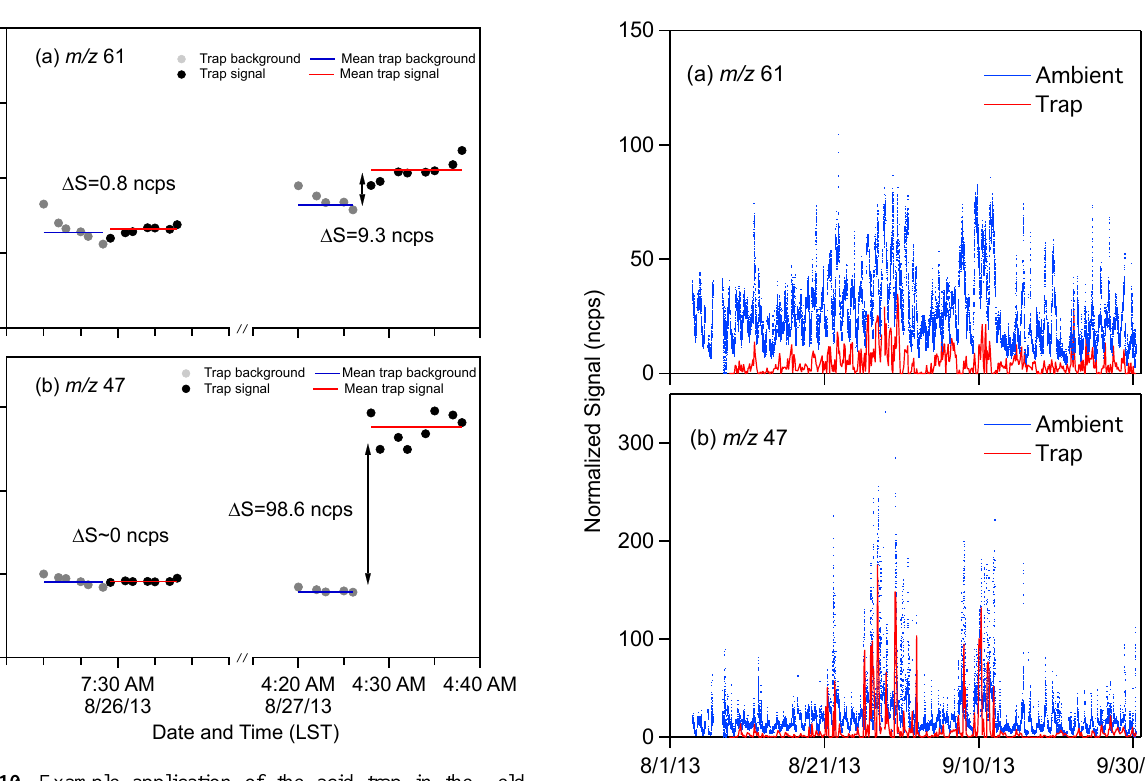
Figure 10. Example application of the acid trap in the field (SLAQRS campaign in East St. Louis, USA) for (a) m/z 61 and (b) m/z 47. The left-hand section illustrates a time period when the acid trap measurements are indistinguishable from the trap background ( (cid:49)S ∼ 0), indicating no detectable presence of non-acid interfer- ences. The right-hand section illustrates a time period when there were detectable non-acid interferences at both m/z values ( (cid:49)S > 0).